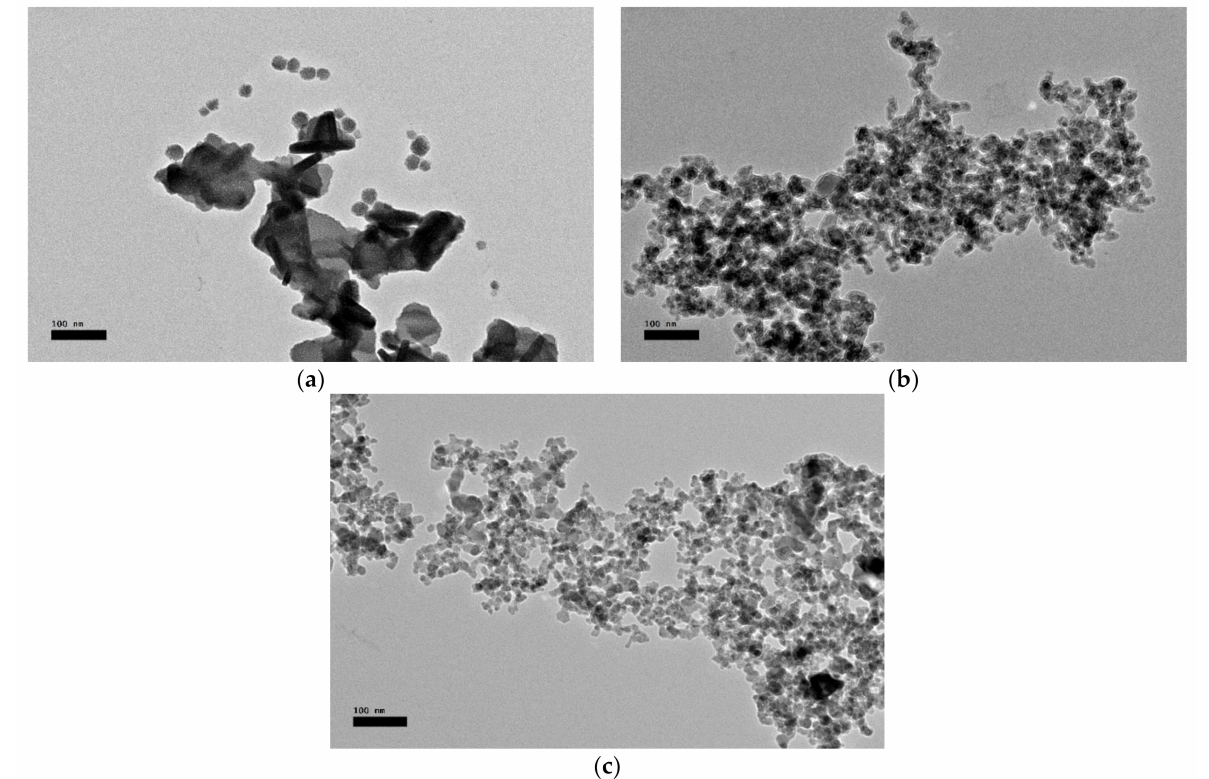
Figure 20. TEM images: ( a ) 0.1 wt% Al 2 O 3 with CTAB nanofluids, ( b ) 0.1 wt% untreated Al 2 O 3 nanofluids, and ( c ) 0.1 wt% plasma-treated Al 2 O 3 nanofluids. The inserted scale bar is 100